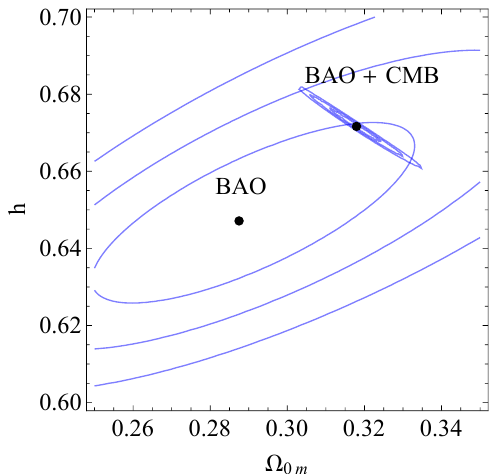
Figure 15. The 1 σ − 3 σ confidence contours in the parametric space ( h − Ω 0 m ) for the BAO data and the BAO + CMB data combination. Notice the dramatic improvement of the constraints when the CMB data points are